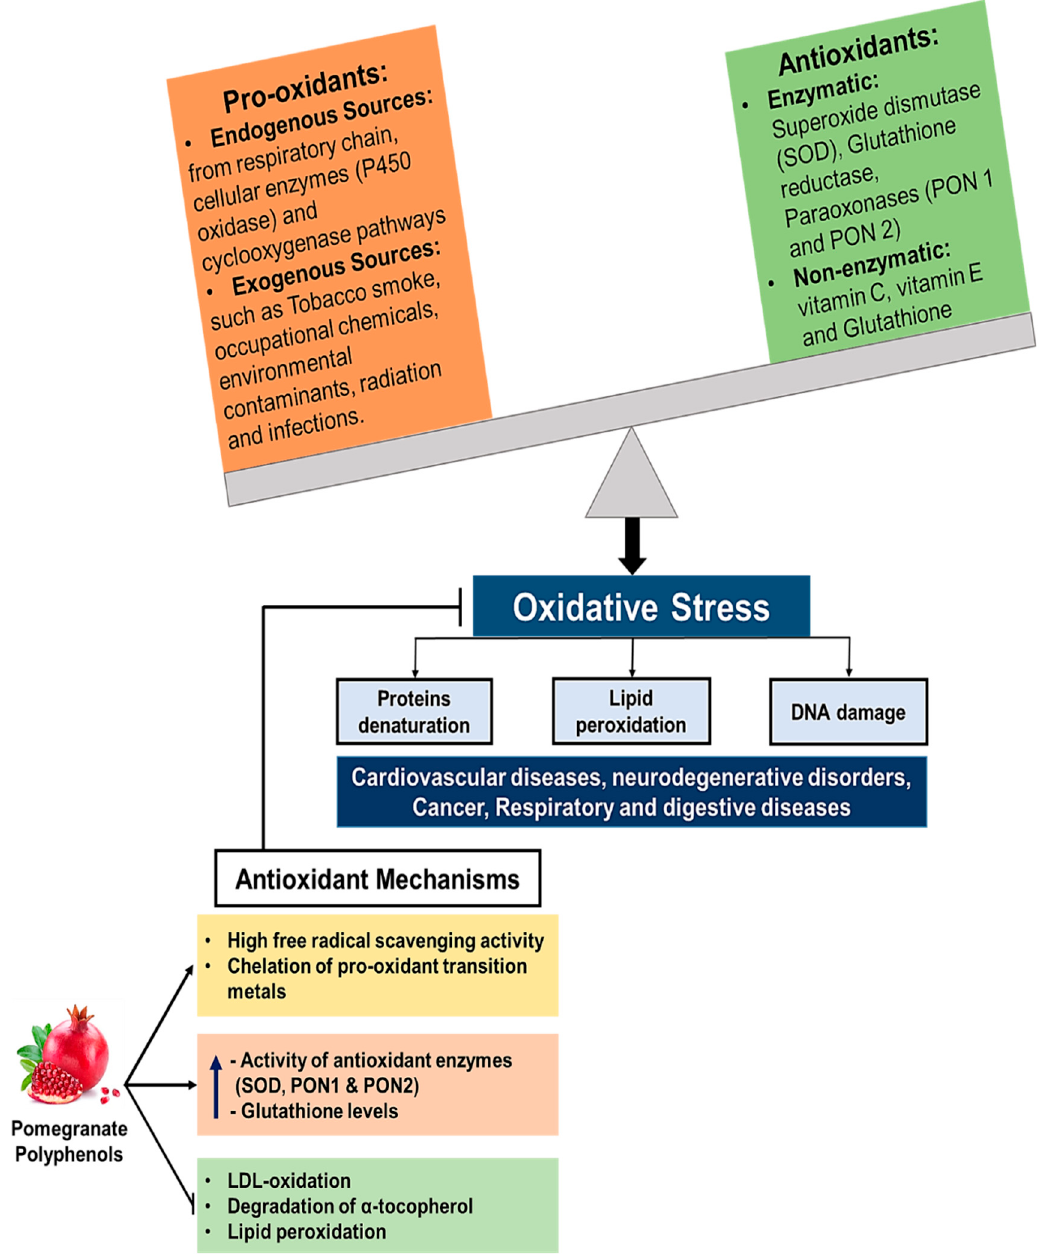
Figure 3. Antioxidant mechanisms of